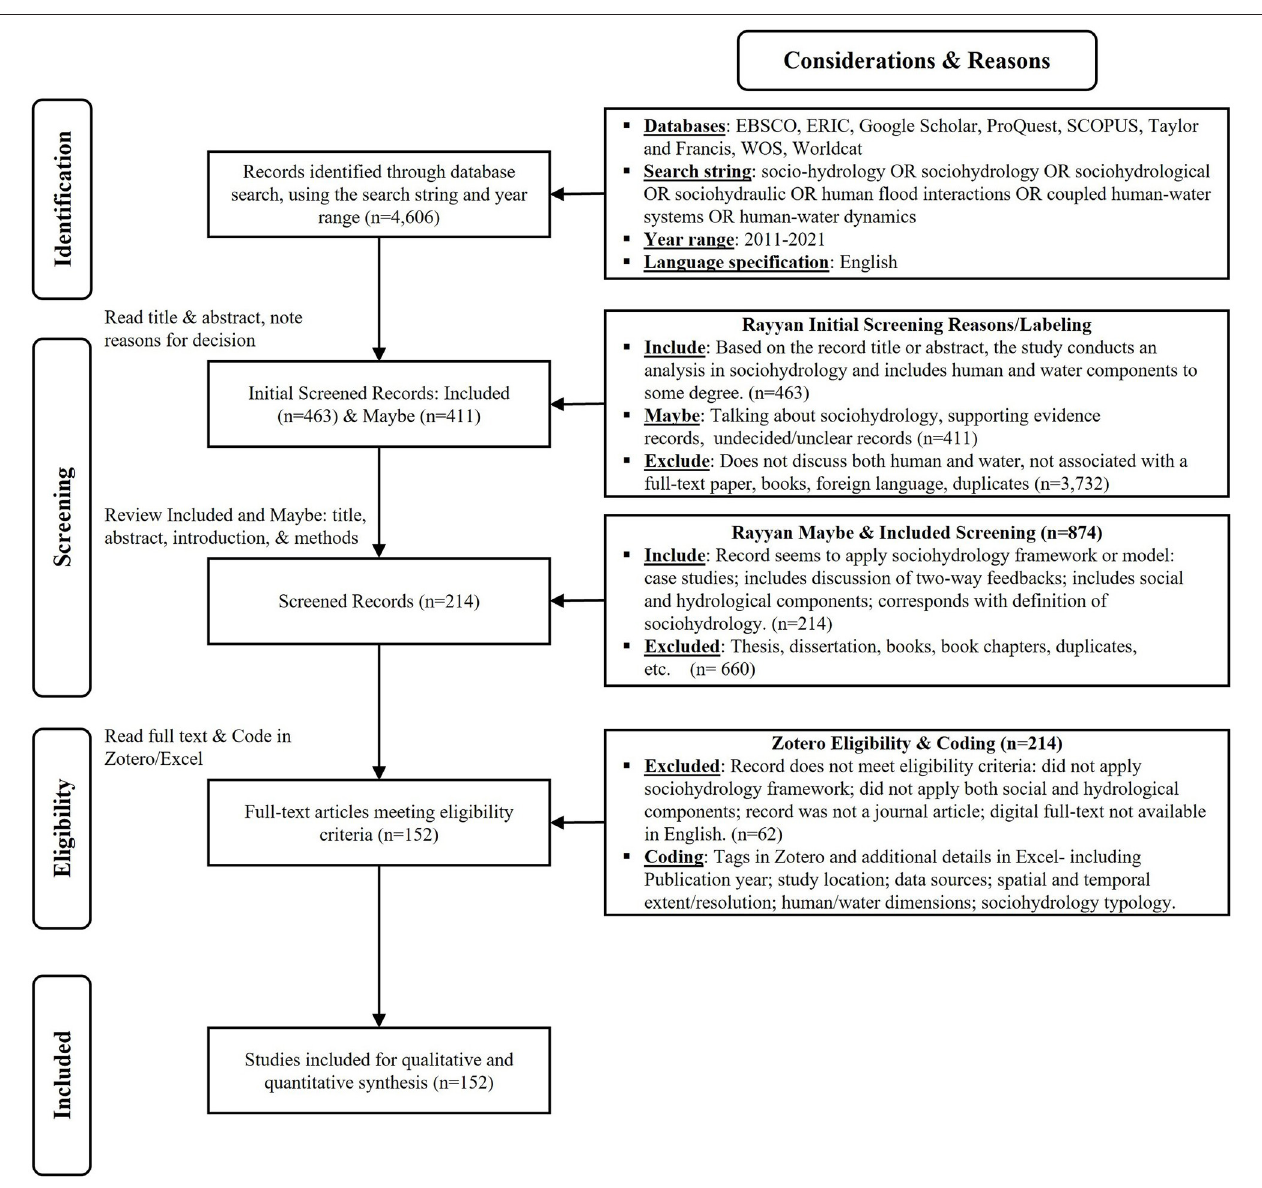
FIGURE 1 | PRSMA flow diagram detailing the systematic review process with study counts and exclusion